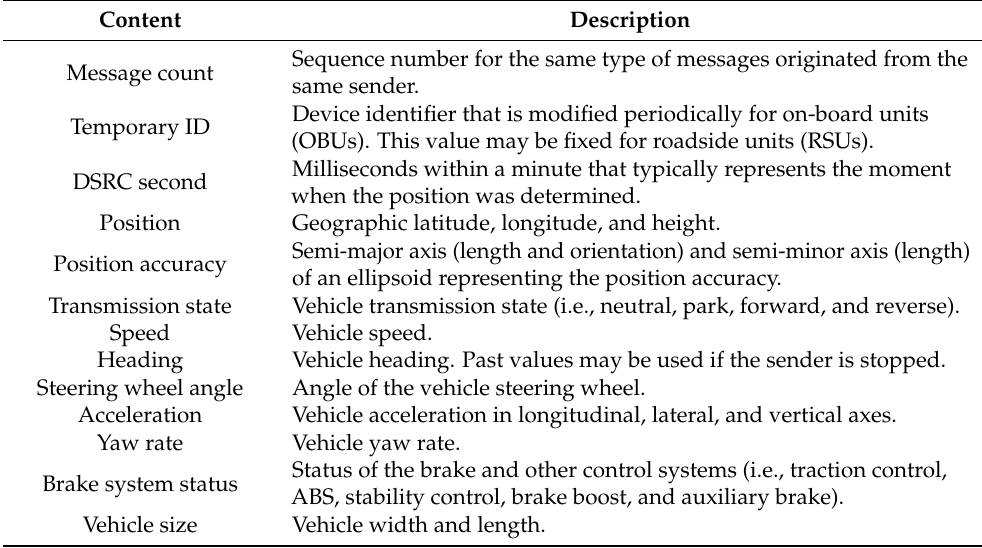
Table 4. Data description for the basic safety message (BSM) core data